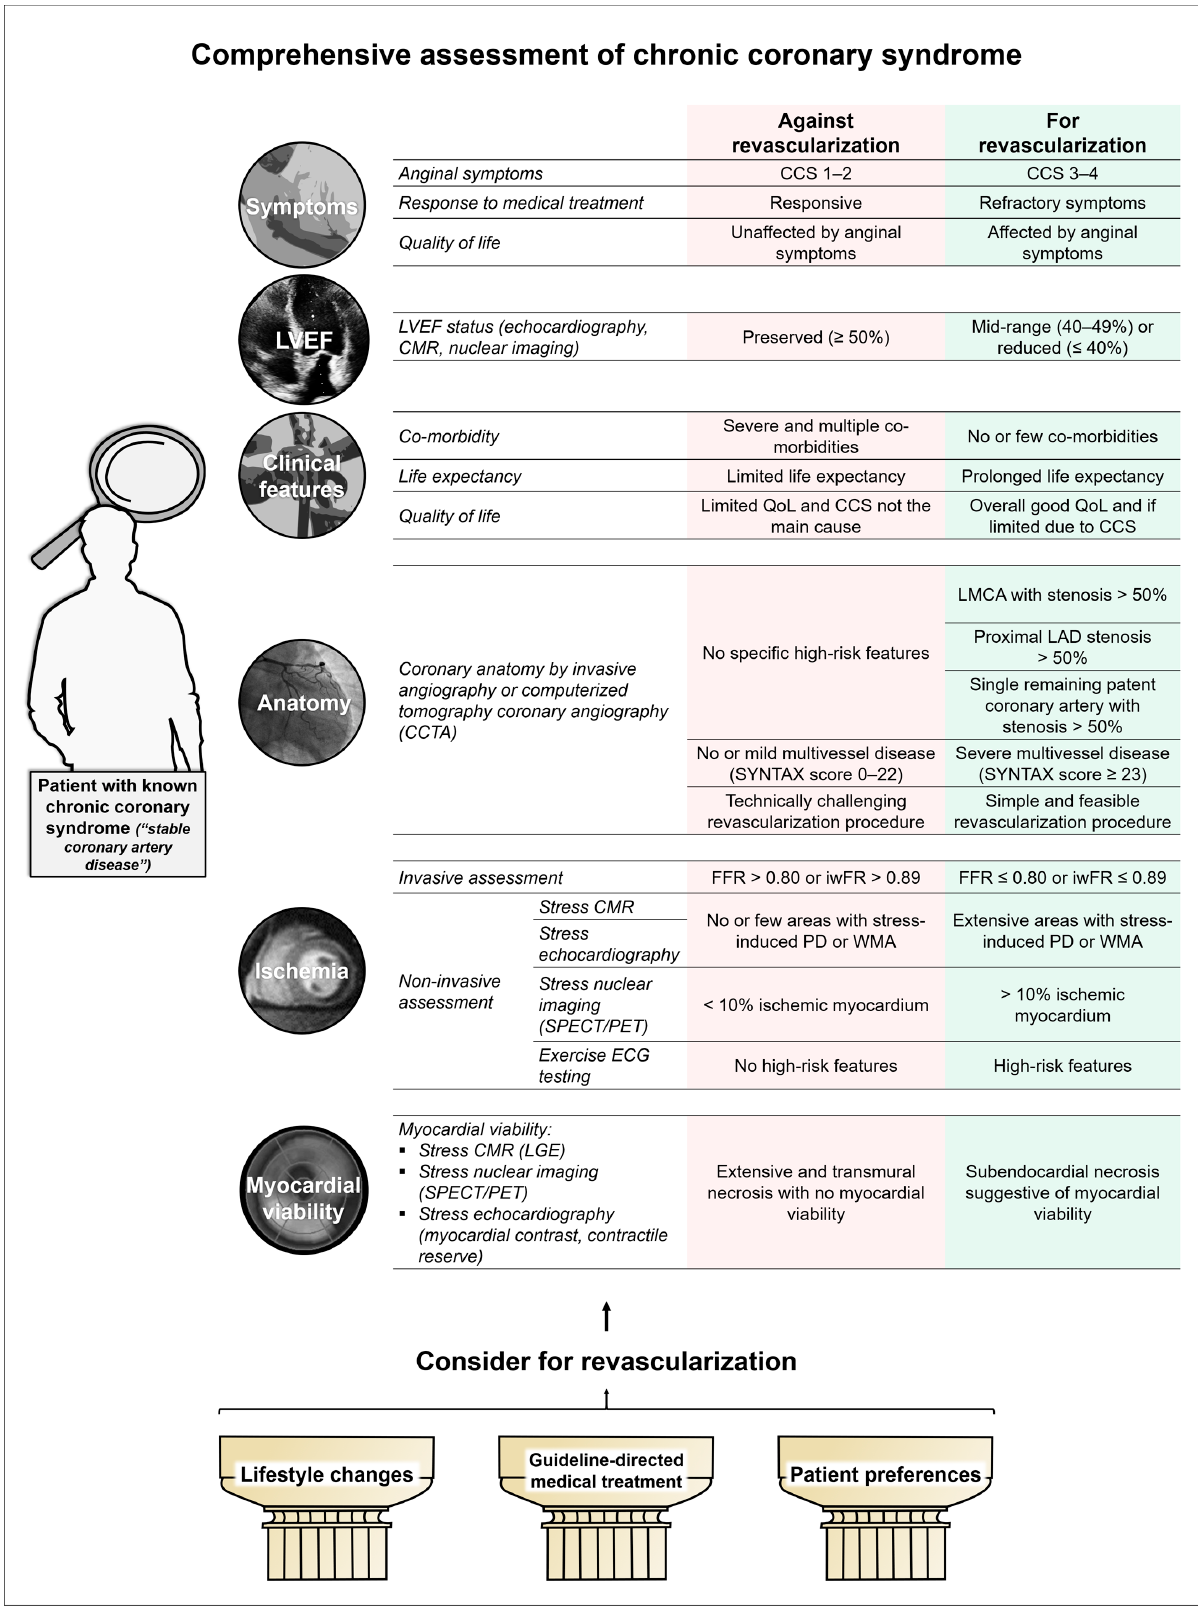
Figure 3. Comprehensive management of chronic coronary syndrome. Lifestyle changes (if needed) and guideline-directed medical treatment must be implemented; patient preferences have to be carefully considered. A comprehensive